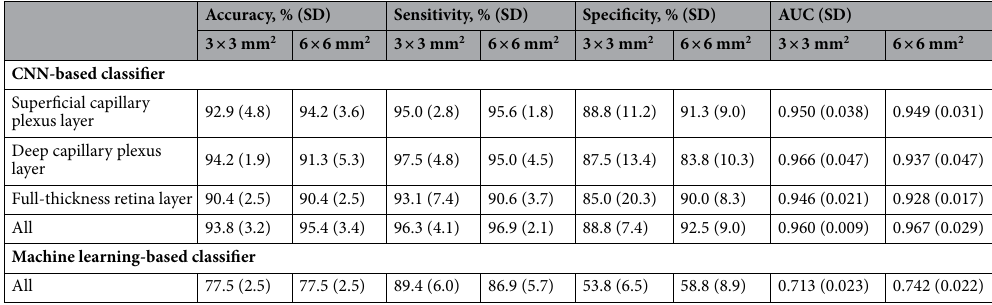
Table 1. Performance of classification task for detecting diabetic retinopathy using the proposed deep learning- and machine learning-based classifiers. AUC area under the curve, CNN convolutional neural network, SD standard